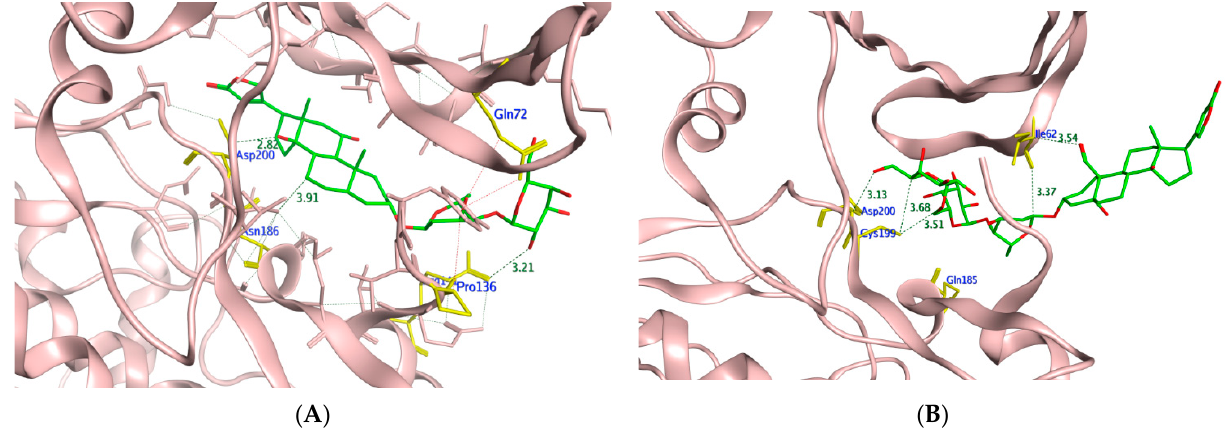
Figure 15. The 3D presentations of the molecular interaction of 16 ( A ) and 20 ( B ) with GSK3 using PDB 1Q5K are illustrated as a green stick model. The interacting amino acids of the binding domain are shown in yellow with the formed H-bonds and H-arene appearing as a green and red dotted line, respectively, with their corresponding distance in Å.